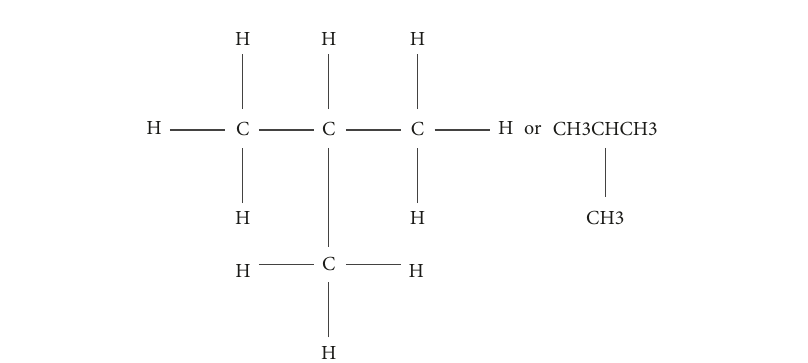
Figure 2: Branched chain of butane (isobutane) and its condensed structural